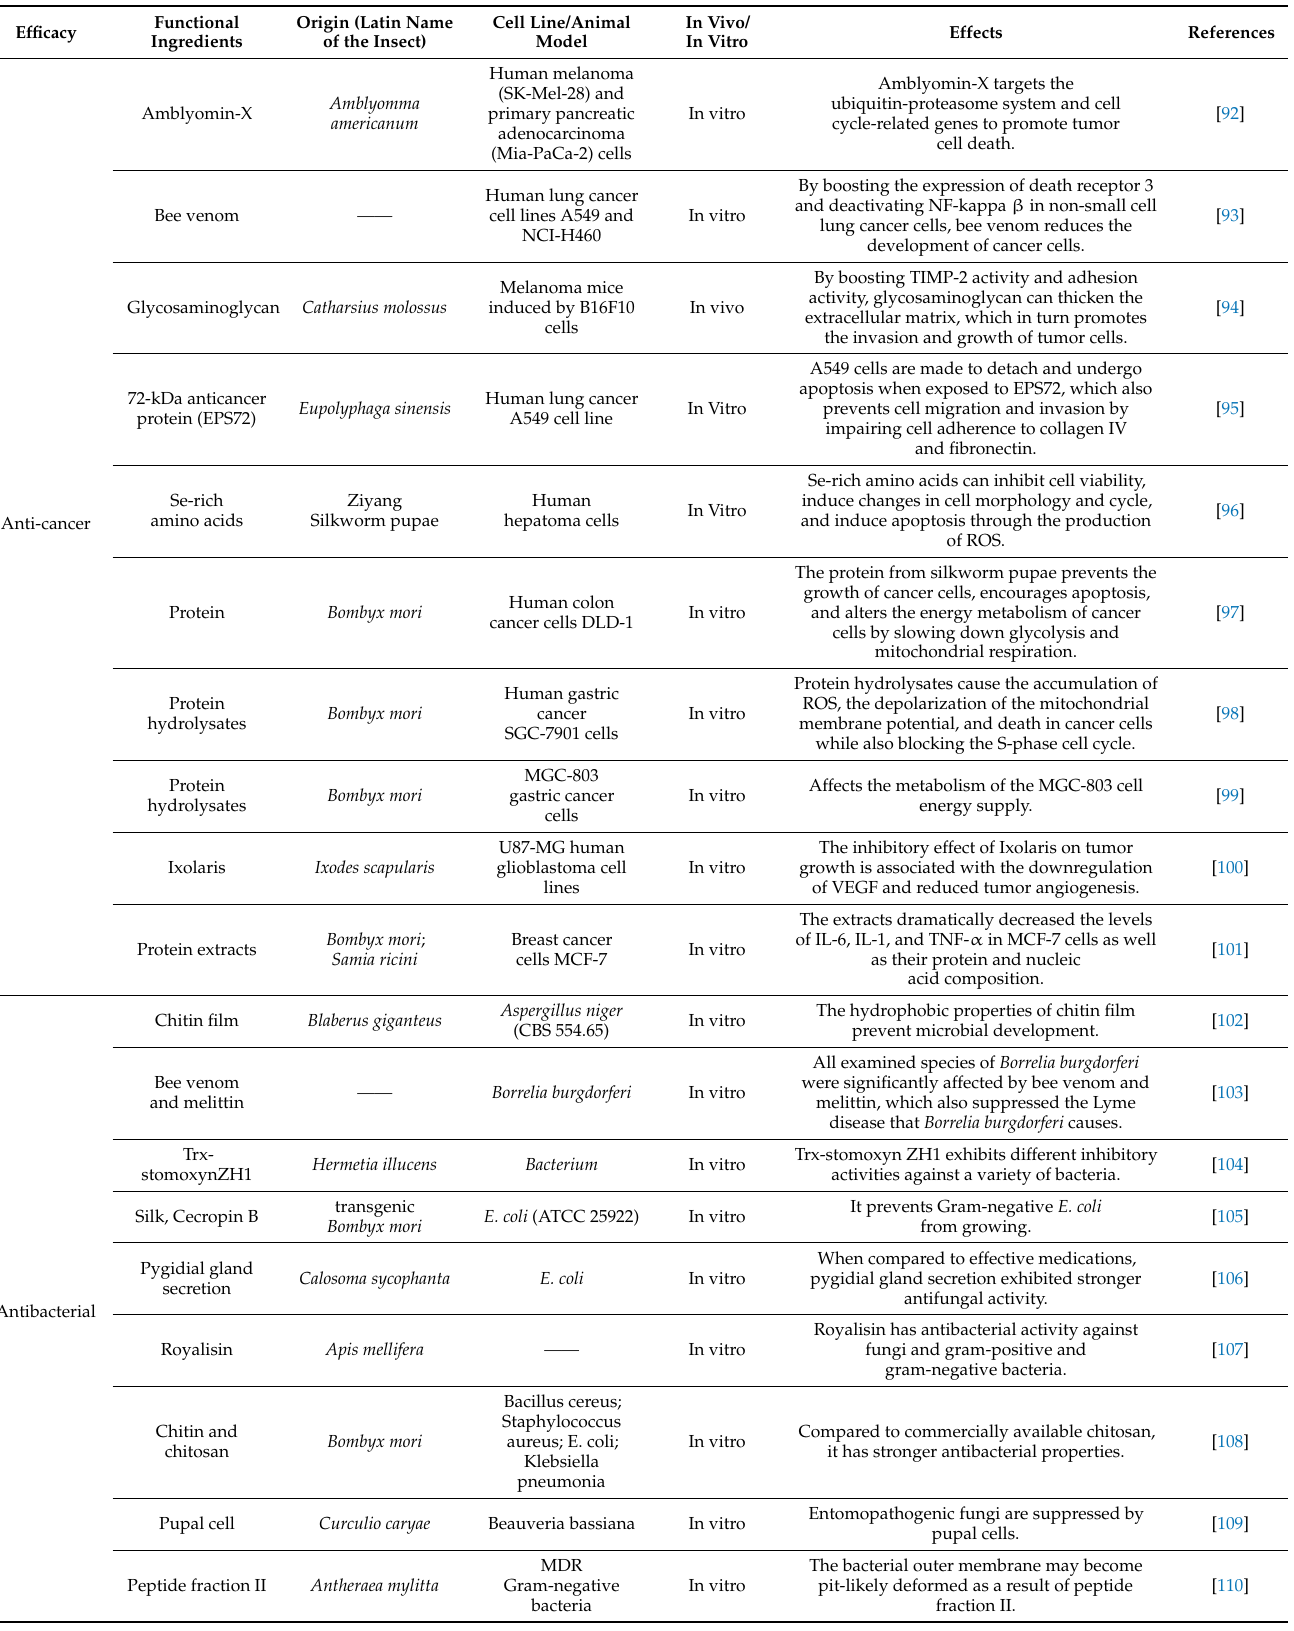
Table 6. Biological functions of insect active